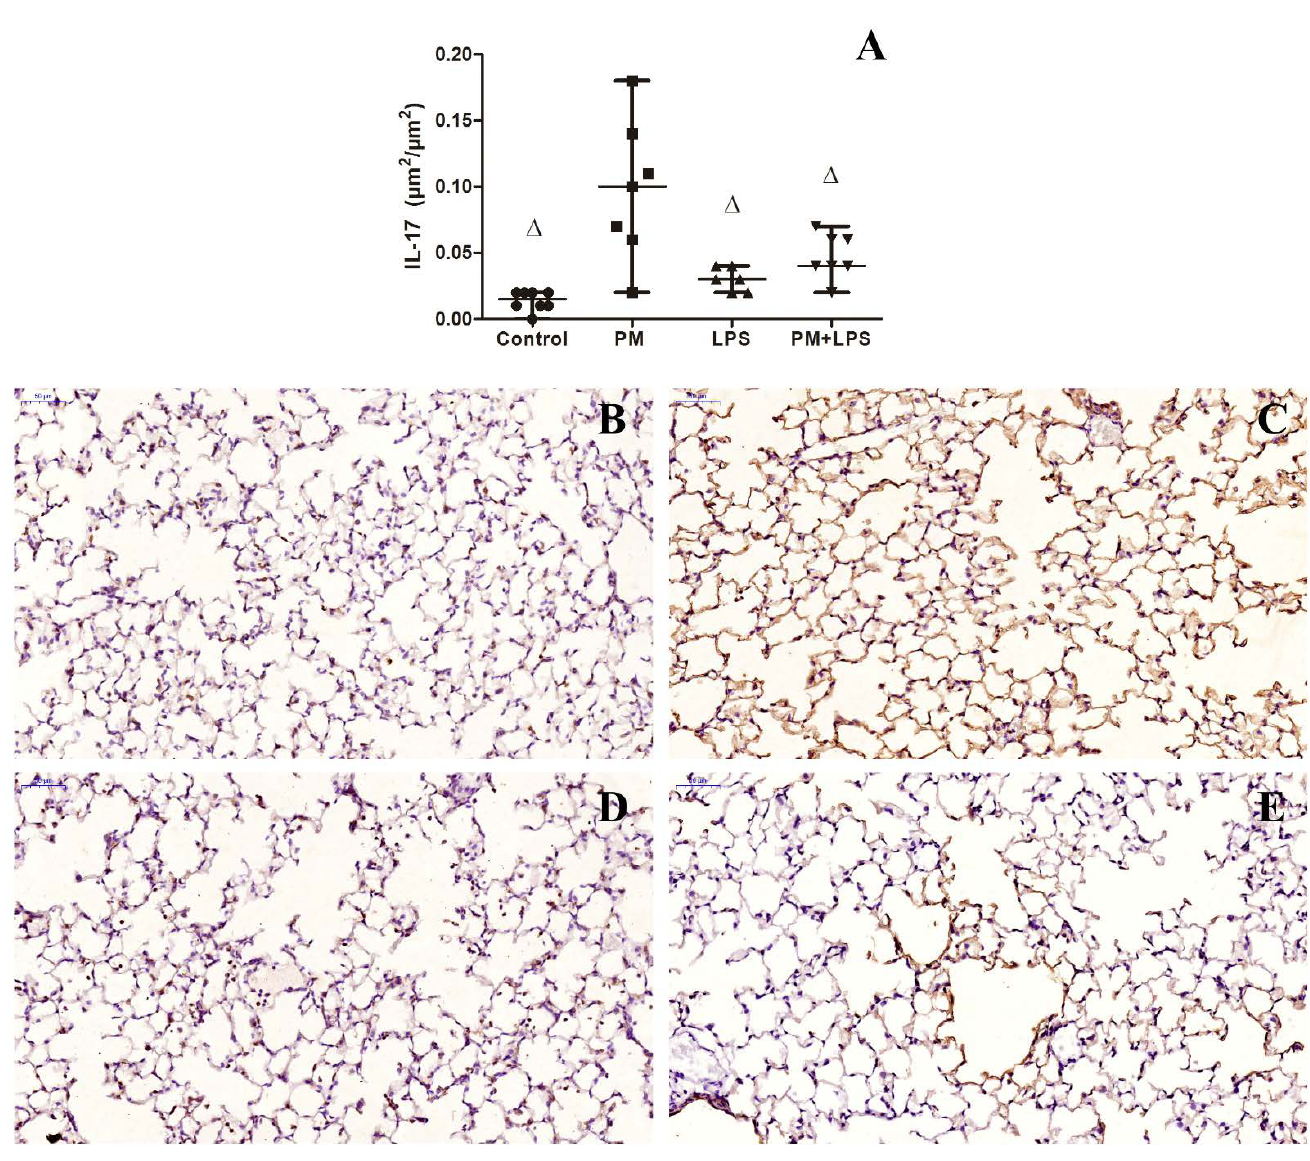
Figure 6. Graphical representation of IL-17 assessment in the lung parenchyma and representative photomicrographs of immunostained lung tissue. ( A ) Graphical representation of IL-17 in the lung parenchyma. Representative photomicrographs of the lung parenchyma immunostained with anti- IL-17 antibody: ( B ) control group, ( C ) PM group, ( D ) LPS group, and ( E ) PM+LPS group. The IL-17 staining has a different pattern in each group. The PM group exhibits intense positive stains for IL-17 mostly in the epithelial cells. The LPS group exhibits positive stains for IL-17 mostly in the inflammatory. The PM+LPS group also exhibits intense positive stains for IL-17 mostly in the epithelial cells, however with a very irregular distribution, staining mainly the alveolar ducts. Each point of the graph represents one animal and bars show the median. ∆ p < 0.05 compared to the PM group. Scale bars = 50 µ